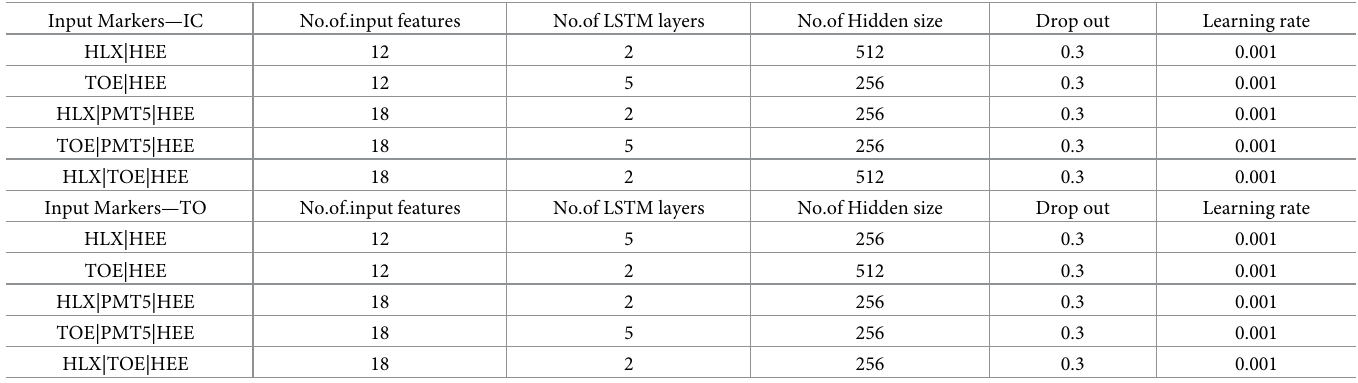
Table 2. Hyper-parameter set for optimum performance. Input